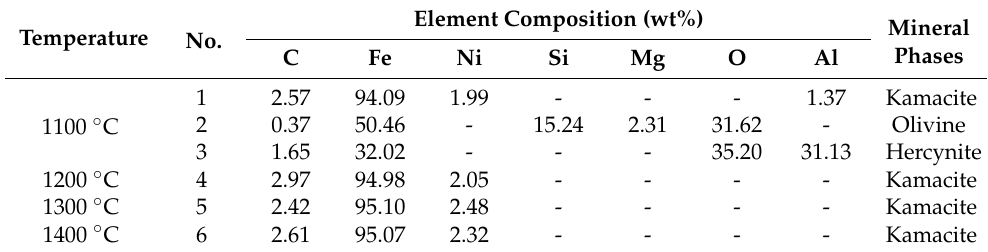
Table 5. EDS analysis results of reduction product for areas in Figure 12.